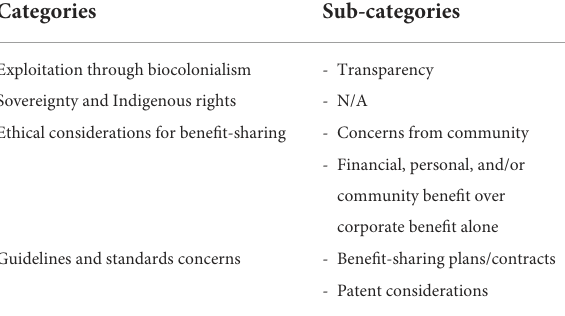
TABLE 2 The main categories and sub-categories identified in the scoping